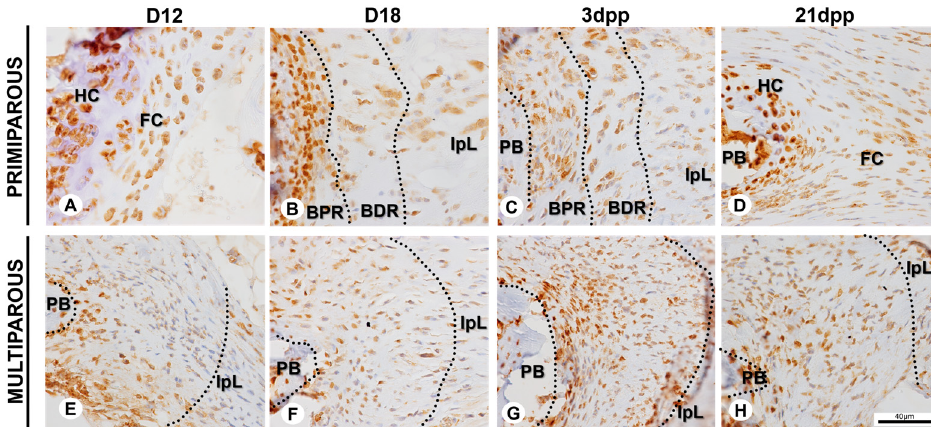
Figure 4. Immunopositive cells for Runx-2 at the symphyseal enthesis during pregnancy and post- partum in primiparous and multiparous senescent female mice. ( A – D ) Runx-2 immunostaining at hyaline cartilage (HC), fibrocartilage (FC), bone proximal region (BPR), bone distal region (BDR), and interpubic ligament (IpL). ( E – H ) Runx-2 immunostaining at the symphyseal enthesis and IpL. If distinguishable, demarcated areas with dotted lines correspond approximately to BPR and BDR.